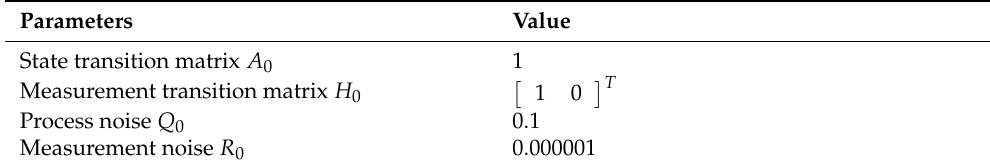
Table 1. Parameters of data fusion method based on gyro and accelerometer in simulation.